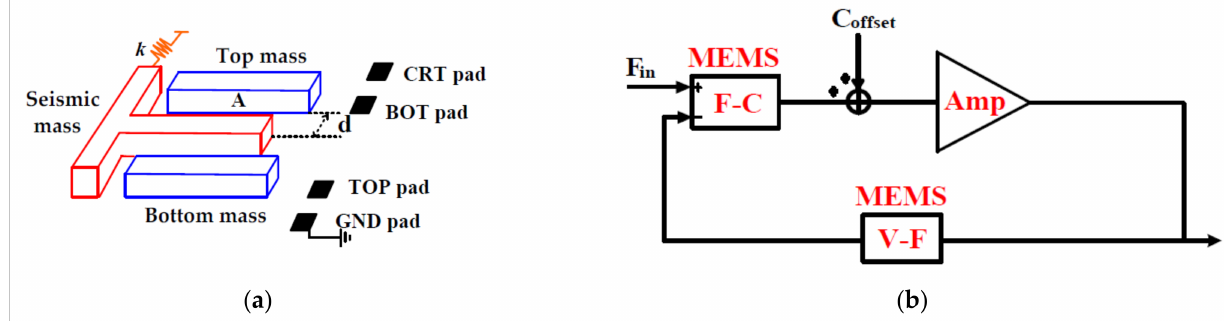
Figure 1. ( a ) MEMS architecture. ( b ) Common model of MEMS and interface signal